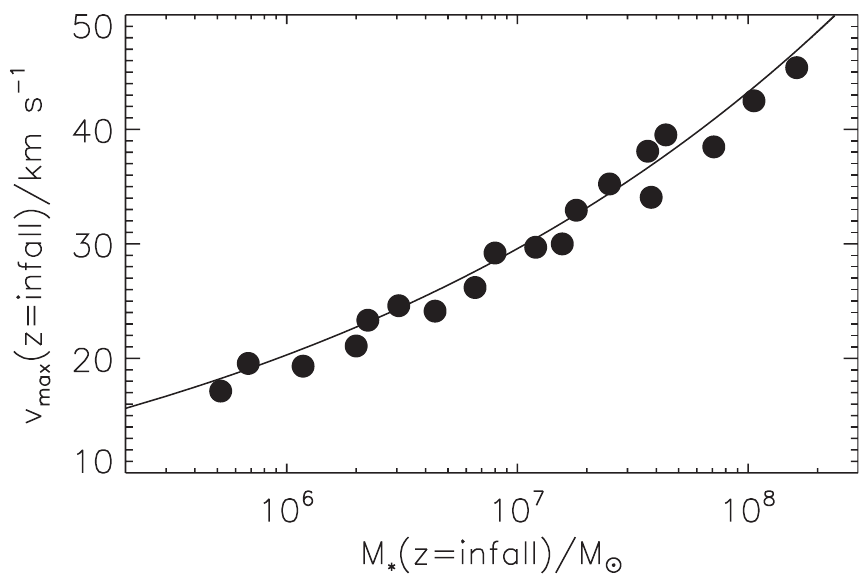
Figure 17. DMO subhaloes maximum velocity v max as function of their stellar mass, M ∗ , at infall time. The stellar mass change with v infall is synthesised by the data fit from Equation (7), shown as a solid line (figure reproduced from